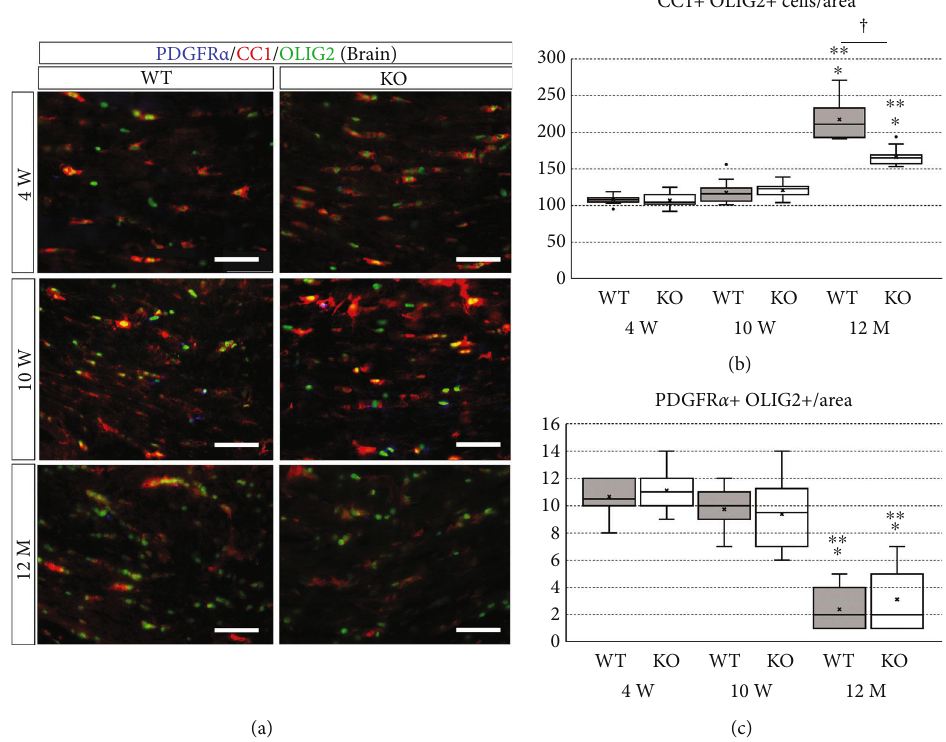
Figure 8: Immunostaining of oligodendrocytes and their progenitor cells in brain sections. Wild-type (WT) and miR-23-27-24 cluster knockout (KO), n = 6 per group. (a) Brain sections were immunostained for platelet-derived growth factor receptor α (PDGFR α ), a marker of oligodendrocyte progenitors, CC1, a marker of mature oligodendrocytes, and OLIG2, a broad marker of oligodendrocytes. Scale bars: 50 μ m. (b) Number of mature oligodendrocytes showing double positivity for CC1 and OLIG2. The number of mature oligodendrocytes at 12 months of age was signi fi cantly lower compared to that at 4 and 10 weeks of age in both WT and KO mice. The number of mature oligodendrocytes in KO mice was signi fi cantly lower than that in WT mice only at 12 months of age. ∗ Compared to 4-week-old. ∗∗ Compared to 10-week-old. † Comparison between WT and KO mice, p < 0 : 05 . (c) Number of oligodendrocyte progenitors showing double positivity for PDGFR α and OLIG2. The number of oligodendrocyte progenitors at 12 months of age was signi fi cantly lower compared to that at 4 and 10 weeks of age in both WT and KO mice. However, there was no signi fi cant di ff erence in the number of oligodendrocyte progenitors between WT and KO mice at all ages. ∗ Compared to 4-week-old. ∗∗ Compared to 10-week-old, p < 0 : 05